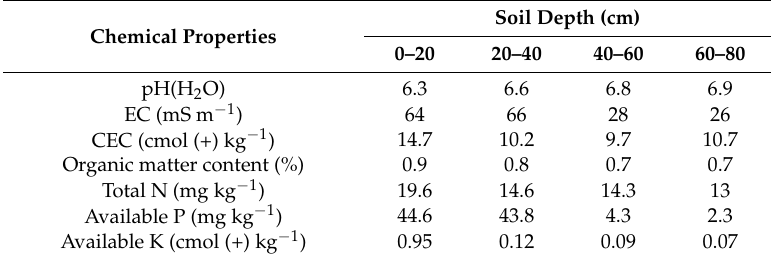
Table 1. Chemical properties of different soil layers of the experimental field site.